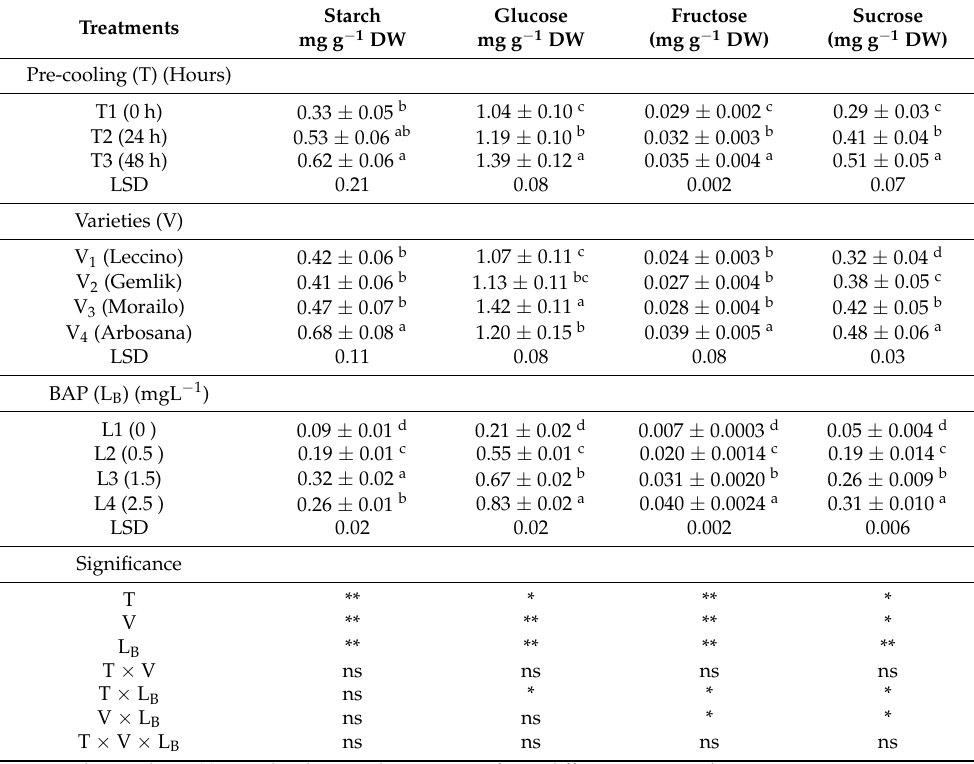
Table 3. Effect of different pre-cooling treatments and varying concentrations of BAP on primary metabolites of different olive genotypes cultured within micropropagation system using